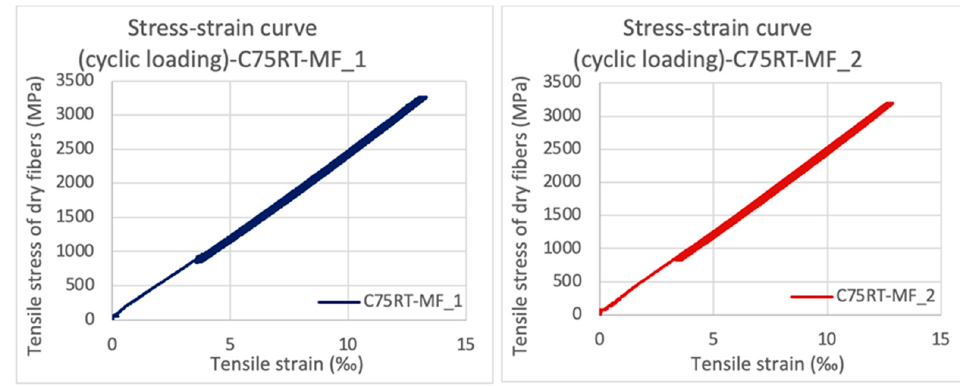
Figure 9. Stress–strain curves for low-cycle fatigue with max load 75% of the tensile strength.